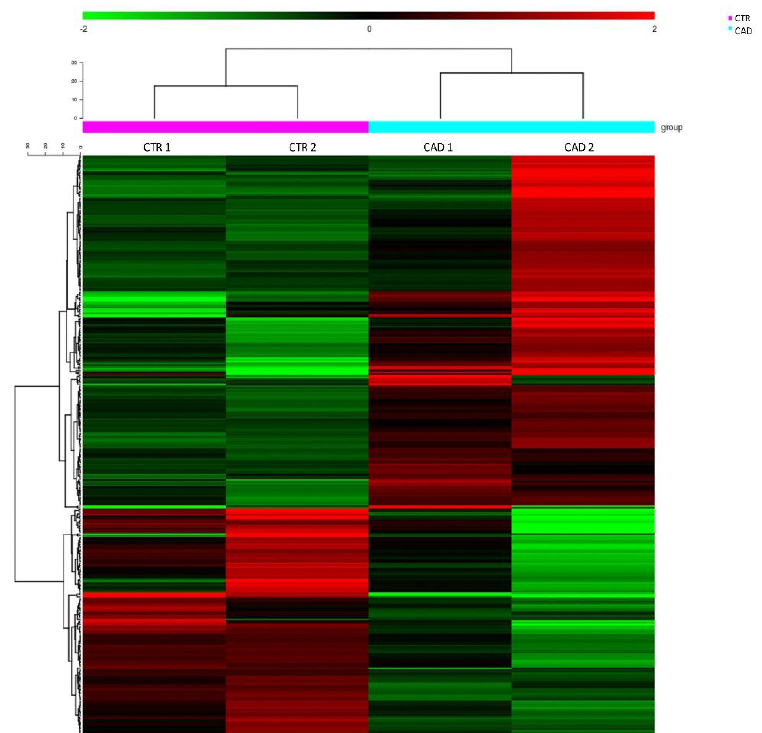
Figure 1. Heat Map resulting from RNA sequencing in the comparison coronary artery disease (CAD) vs. control subjects (CTR). The Heat Map showed a clear similar mRNA expression pattern between patients of the same group of study and a profile considerably different between each category of patients. In green are represented the downregulated mRNAs compared to the group set as control; in red are represented the upregulated mRNAs compared to the group set as control. RNA-seq results showed differentially alternative splicing events (AS) in CAD PBMCs. Filtering for a statistically significant Splicing-Index Fold-Change (SI-FC ≥ ±1.5), we observed 113 differentially regulated alternative splicing events (24 upregulated and 89 downregulated) in 86 distinct genes (Figure 2 and Table 2).